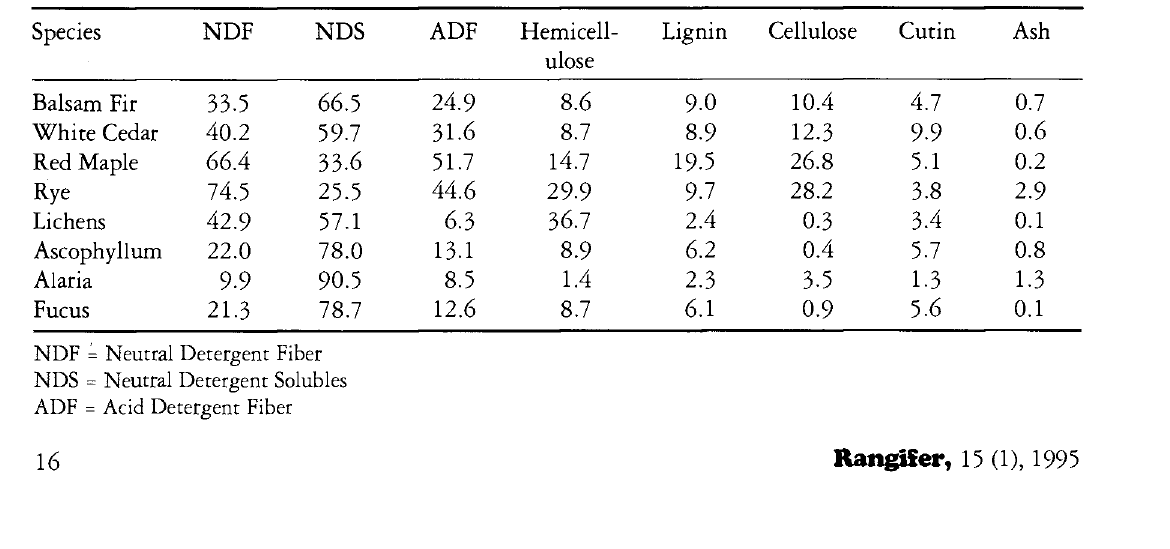
Table 2. Detergem t analysis results for seaweed and ungulate forages. Values are % DM. Species N